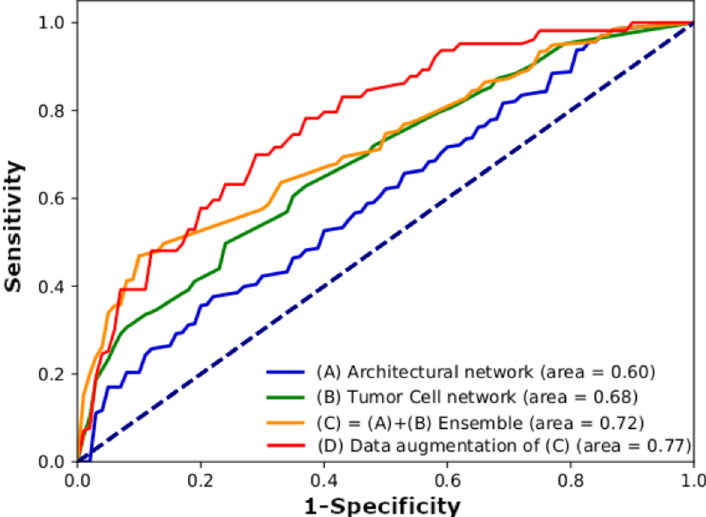
Figure 2. Comparison of the performance between mono-scale histopathology image processing network ( A , B ) and multi-scale histopathology image processing network ( C , D ) based on ROC area under the curve (AUC). ( A ) Architectural network (100× magnification). ( B ) Tumor cell network (400× magnification). ( C ) Architectural and tumor cell network ensemble. ( D ) Architectural and tumor cell network with data augmentation. AUC scores were calculated using the five-fold test set in cohort I ( n = 302).